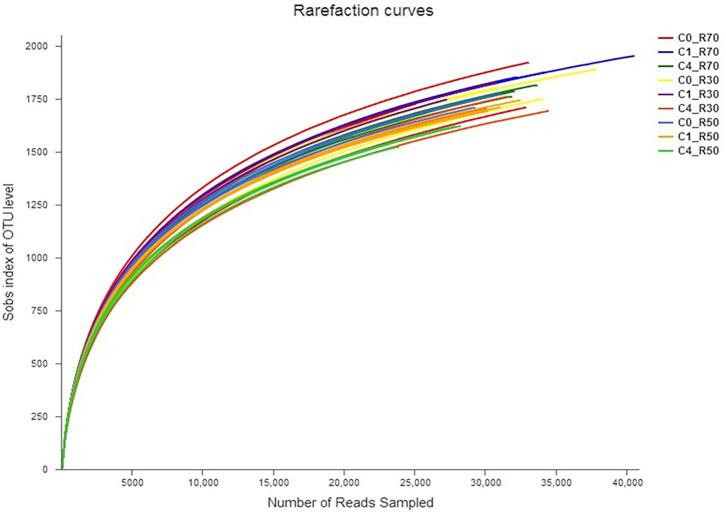
Rarefaction curve showing bacterial richness across samples. C0_R70: control with 70% high roughage; C1_R70: 1% camelina oil level with 70% high roughage; C4_R70: 4% camelina oil level with 70% high roughage; C0_R30: control with 30% low roughage; C1_R30: M1: 1% camelina oil level with 30% low roughage; C4_R30: 4% camelina oil level with 30% low roughage; C0_R50: control with 50% medium roughage; C1_R50: M1: 1% camelina oil level with 50% medium roughage; C4_R50: 4% camelina oil level with 50% medium roughage.